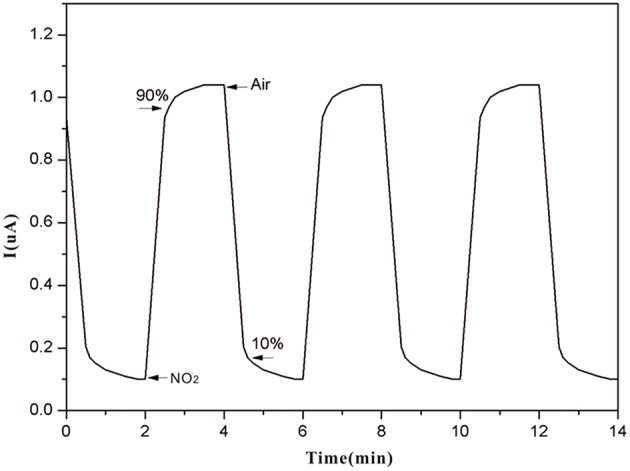
Sensor response to repeated exposures to 100 ppm NO2.